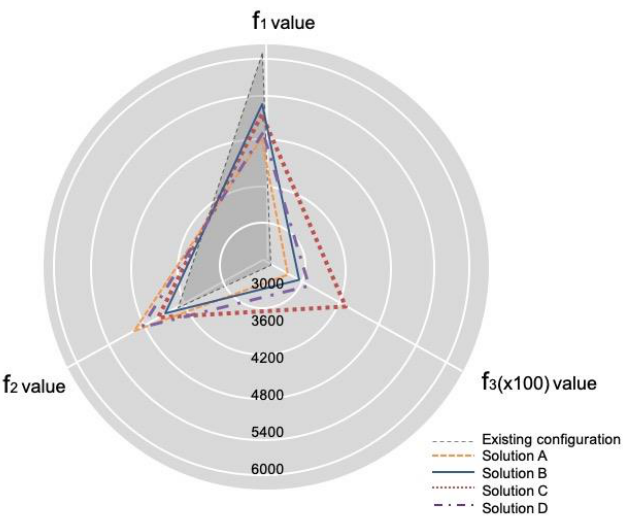
Figure 4. The fitness values of existing configuration and Pareto optimal solutions .